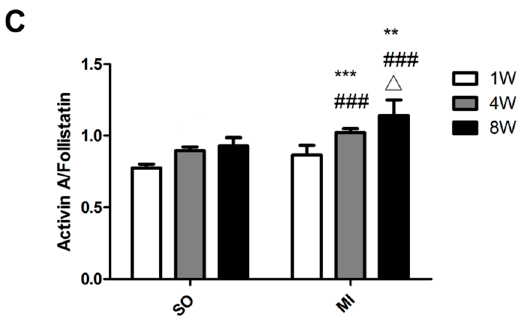
Figure 4. Expression levels of activin A, follistatin, BNP, caspase-3 and ERS-related molecules in the left ventricular noninfarction area.